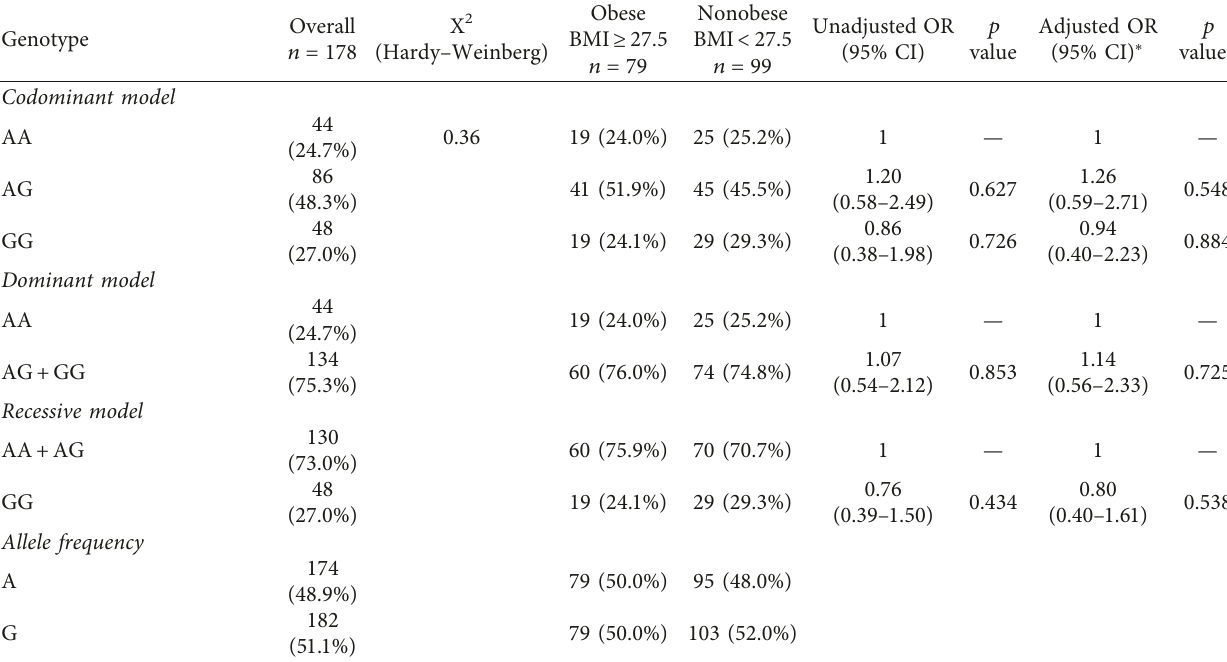
Table 2: Genotype distribution and allele frequency of ADRB2 rs1042713 in obese and nonobese groups.